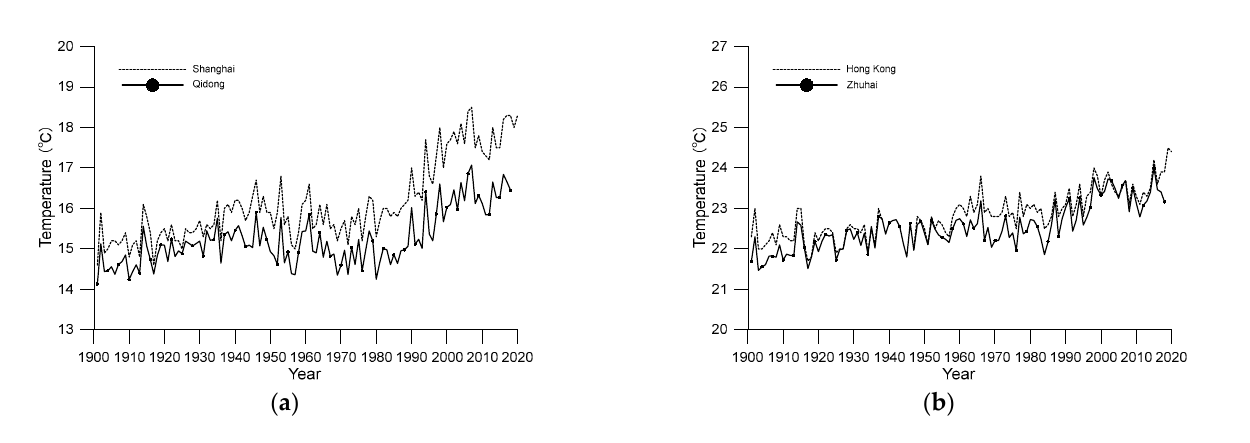
Figure 3. Comparison of annual average air temperature between the two target cities and their adjacent rural areas from 1901 to 2020 (( a ) Shanghai and Qidong; ( b ) Hong Kong and Zhuhai).